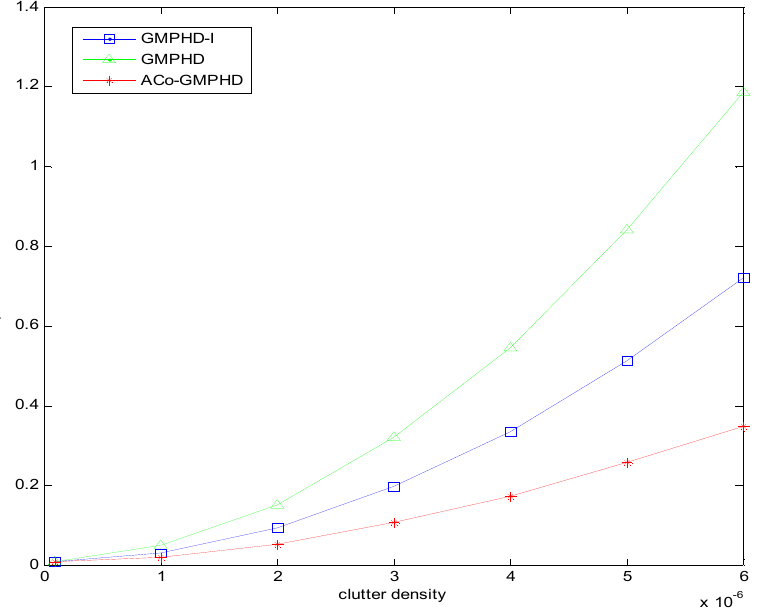
Figure 7. The computation time of the three filters.